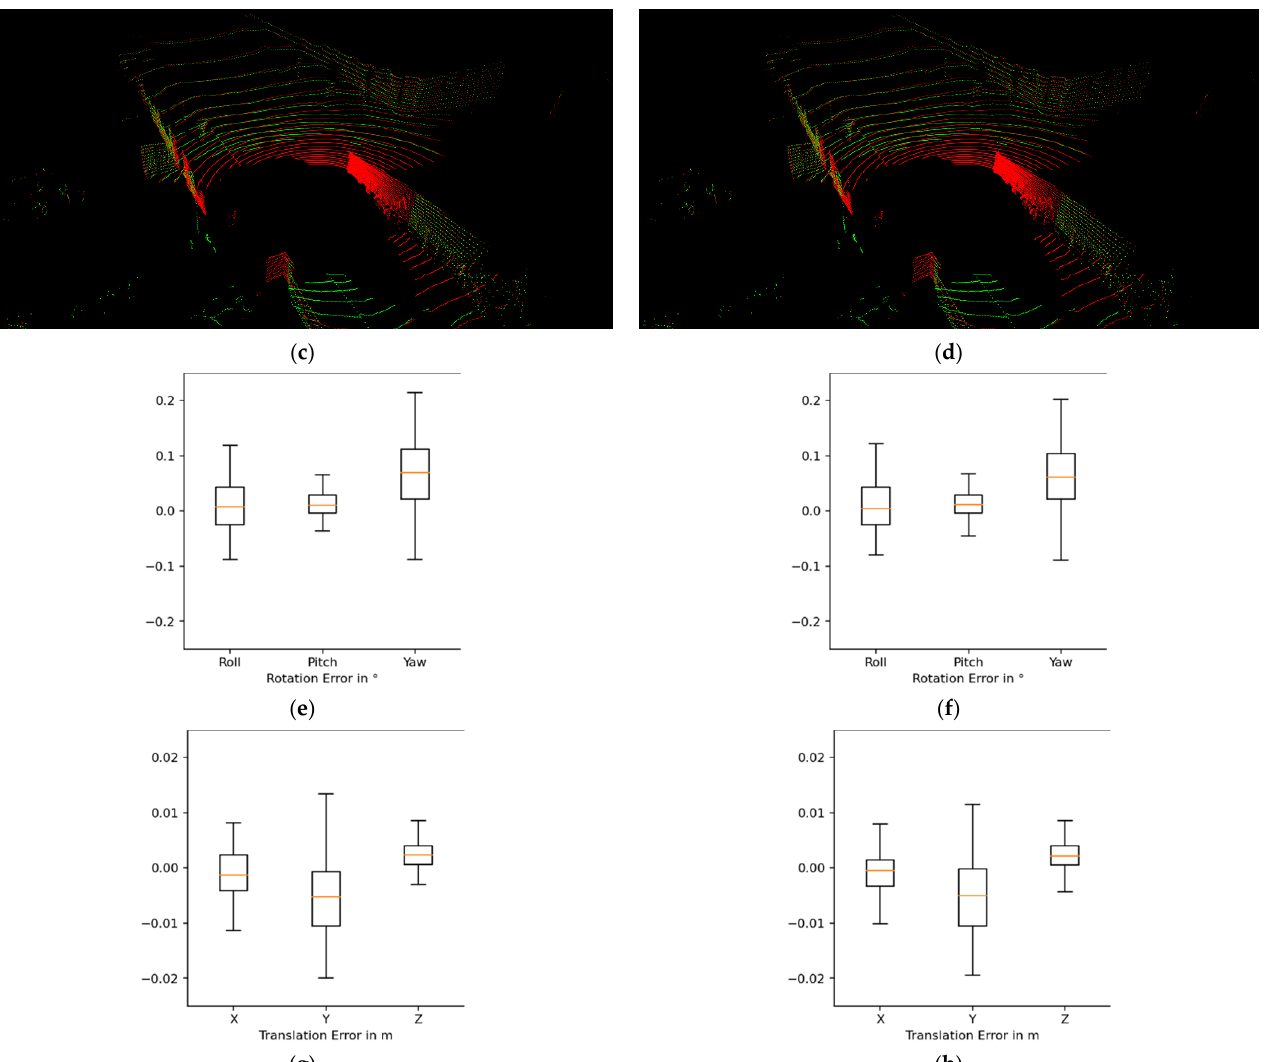
Figure 7. Calibration results and error distribution when temporal filtering was applied to the Oxford dataset. ( a ) Transformation by randomly sampled deviations from Rg1. ( b ) Transformation by randomly sampled deviations from Rg1. ( c ) Calibration results from random deviations shown in ( a ). ( d ) Calibration results from random deviations shown in ( b ). ( e ) Rotation error for the results shown in ( c ). ( f ) Rotation error for the results shown in ( d ). ( g ) Translation error for the results shown in ( c ). ( h ) Translation error for the results shown in ( d ).